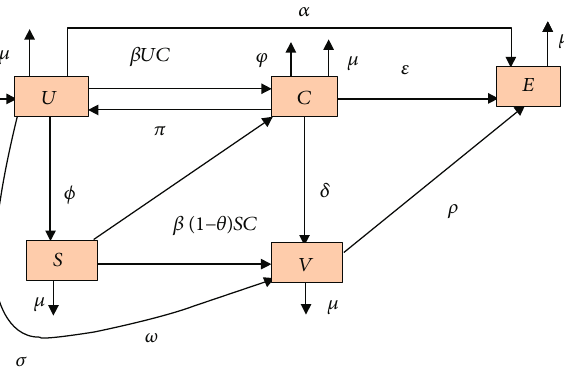
Figure 1: Schematic fi gure of crime